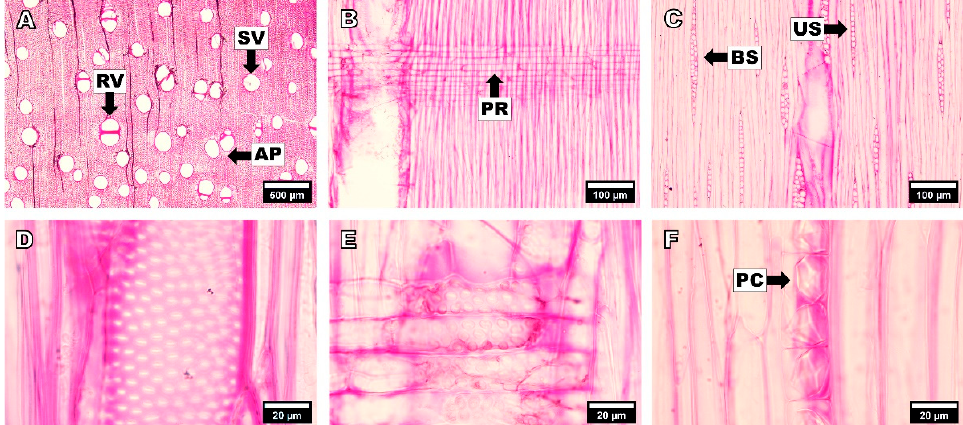
Figure 2. Optical micrographs of Acacia hybrid . Cross-section ( A ), radial section ( B ), tangential section ( C ), intervessel pits ( D ), vessel-ray pits ( E ), and mineral inclusions ( F ). Solitary vessel (SV), radial multiple vessel (RV), axial parenchyma (AP), procumbent body ray (PR), uniseriate ray (US), biseriate ray (BS), and prismatic crystal (PC).